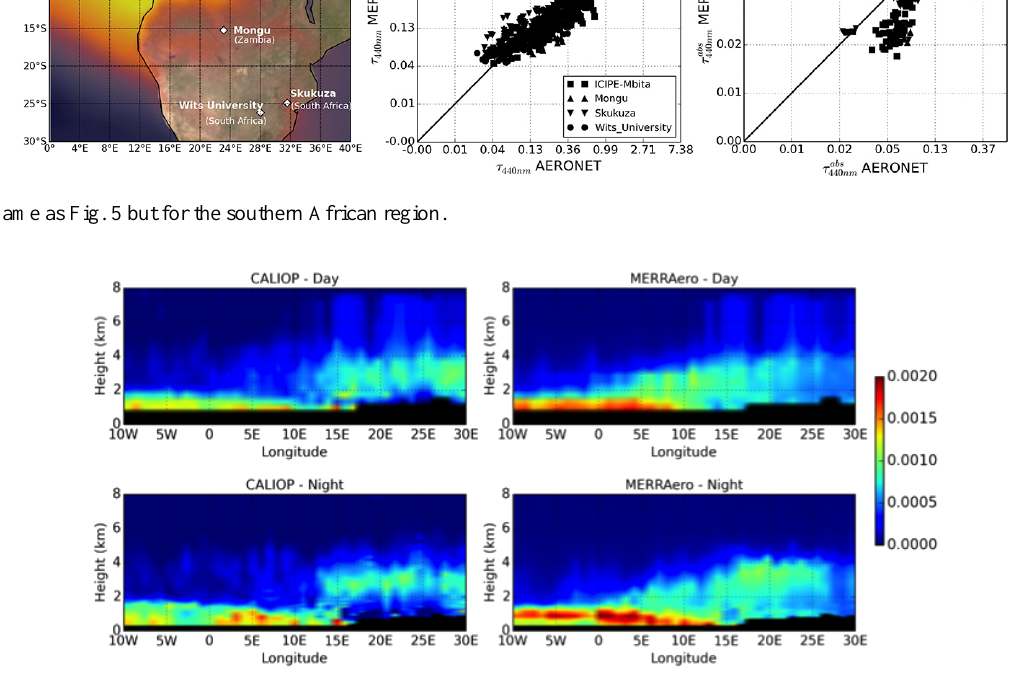
Figure 11. Same as Fig. 6 but for the southern African region (10 ◦ W–30 ◦ E, 0–30 ◦ S) during JJA